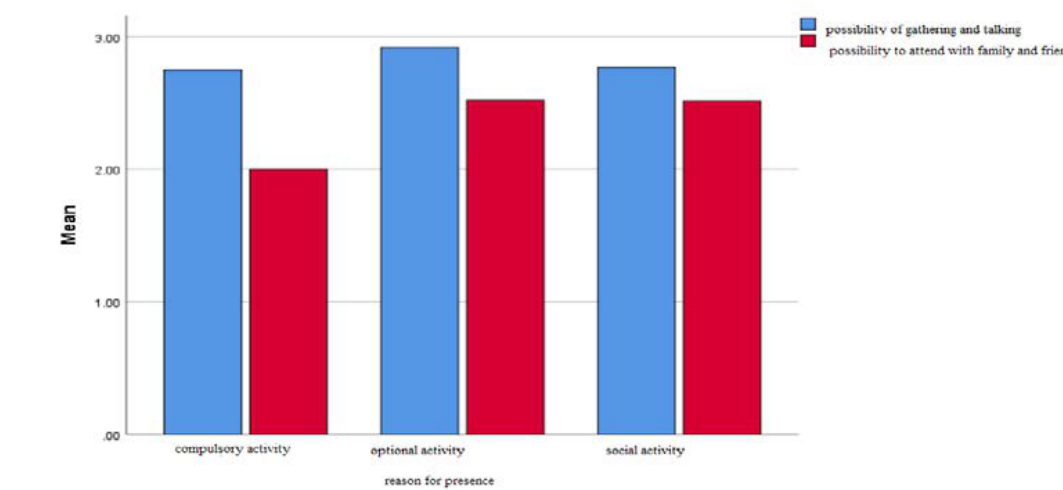
Fig . 9: The difference between items of intimacy Fig. 9: The difference between items of intimacy component